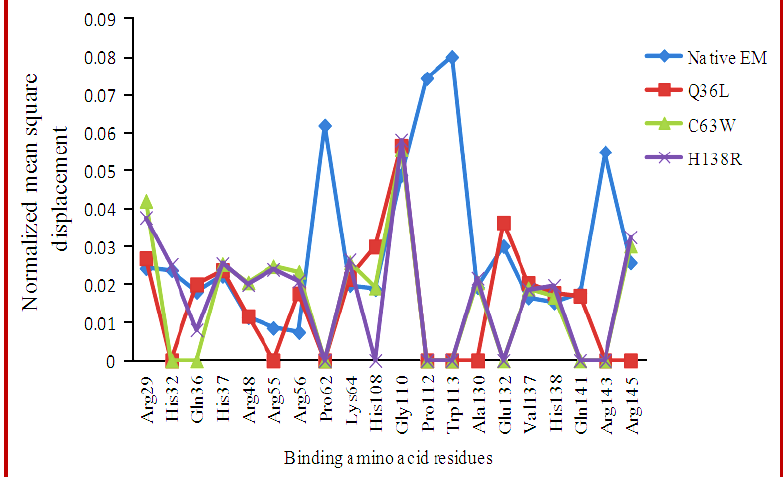
Figure 4: Comparison of normalized mean square displacement of binding amino acids of native and mutant angiogenin